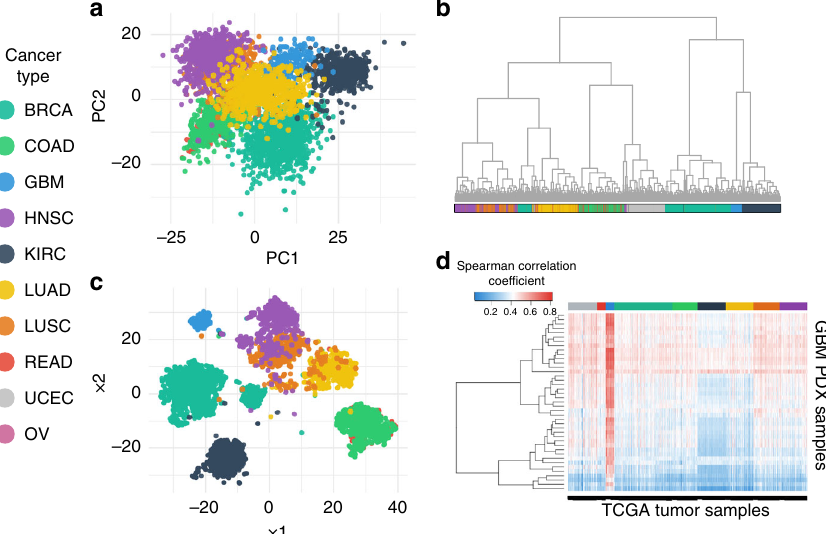
Fig. 2 Clustering of TCGA samples and GBM PDX samples using the L1000 gene set re fl ects cancer types. a PCA plot, b Hierarchical Clustering, and c t- distributed stochastic neighbor embedding (tSNE) plot of 4515 RNA-Seq TCGA tumor samples labeled based on their cancer type by using the expression of only 978 genes. d Heatmap of the Spearman correlation of 41 PDX GBM samples from Mayo Clinic and 4515 tumor samples downloaded from TCGA. Cancer types: BRCA: breast invasive carcinoma, COAD: colon adenocarcinoma, GBM: glioblastoma, HNSC: head-neck squamous cell carcinoma, KIRC: kidney renal clear cell carcinoma, LUAD: lung adenocarcinoma, LUSC: lung squamous cell carcinoma, READ: rectum adenocarcinoma, UCEC: uterine corpus endometrial carcinoma, OV: ovarian